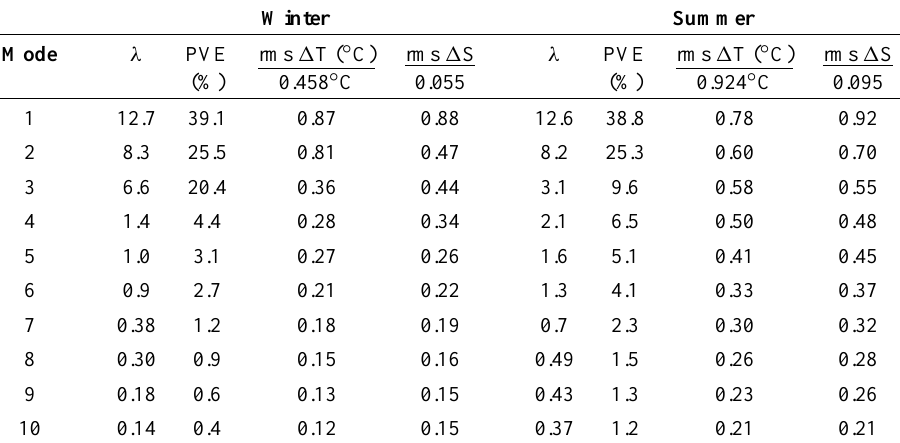
Table 5. The first ten eigenvalues of the covariance matrix of the insitu data in region 9 for winter and summer. The first column contains the eigenvalues. The percentage of the variance explained (PVE, Eq. (3) is shown in the second column. In the remaining two columns for each season, the ratio of the vertical average of the root mean square residual (7b) to the vertically averaged standard deviation (7a) is also shown. This latter is shown only for the layer between 0 and 200m Winter Summer Mode λ PVE rms 1 T ( ◦ C) rms 1 S λ PVE rms 1 T ( ◦ C) rms 1